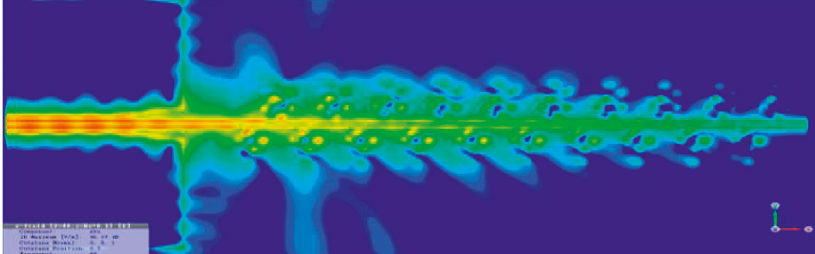
Figure 3: Propagation of the EM energy on the surface of this CP antenna.